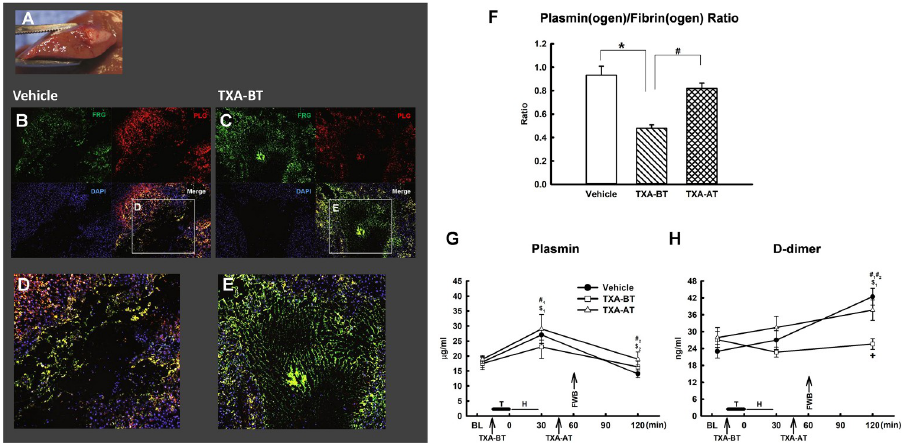
Fig 4. Plasmin(ogen) and fibrin(ogen) at traumatized liver and fibrinolytic activity. (A) Cross section of traumatized liver; (B) and (D) plasminogen and fibrin staining at the injured site of liver of Vehicle; (C) and (E) plasminogen and fibrin staining at the injured site of liver of TXA-BT; (F) Quantification of plasminogen/fibrin ratio at the injured site of liver (n = 8 per group). � : significant difference compared to Vehicle; #: significant difference compared to TXA-AT. (G) and (H) Fibrinolytic Activity (n = 10 per group): (G) Plasmin activity in the plasma; (H) D- dimer levels in the plasma. T: Trauma; H: Hemorrhage; FWB: Fresh Whole Blood. #: Vehicle; &: TXA-BT; $: TXA-AT. # 1 , & 1 and $ 1 : significant difference compared to baseline (BL); # 2 , & 2 and $ 2: significant difference compared to 30min.